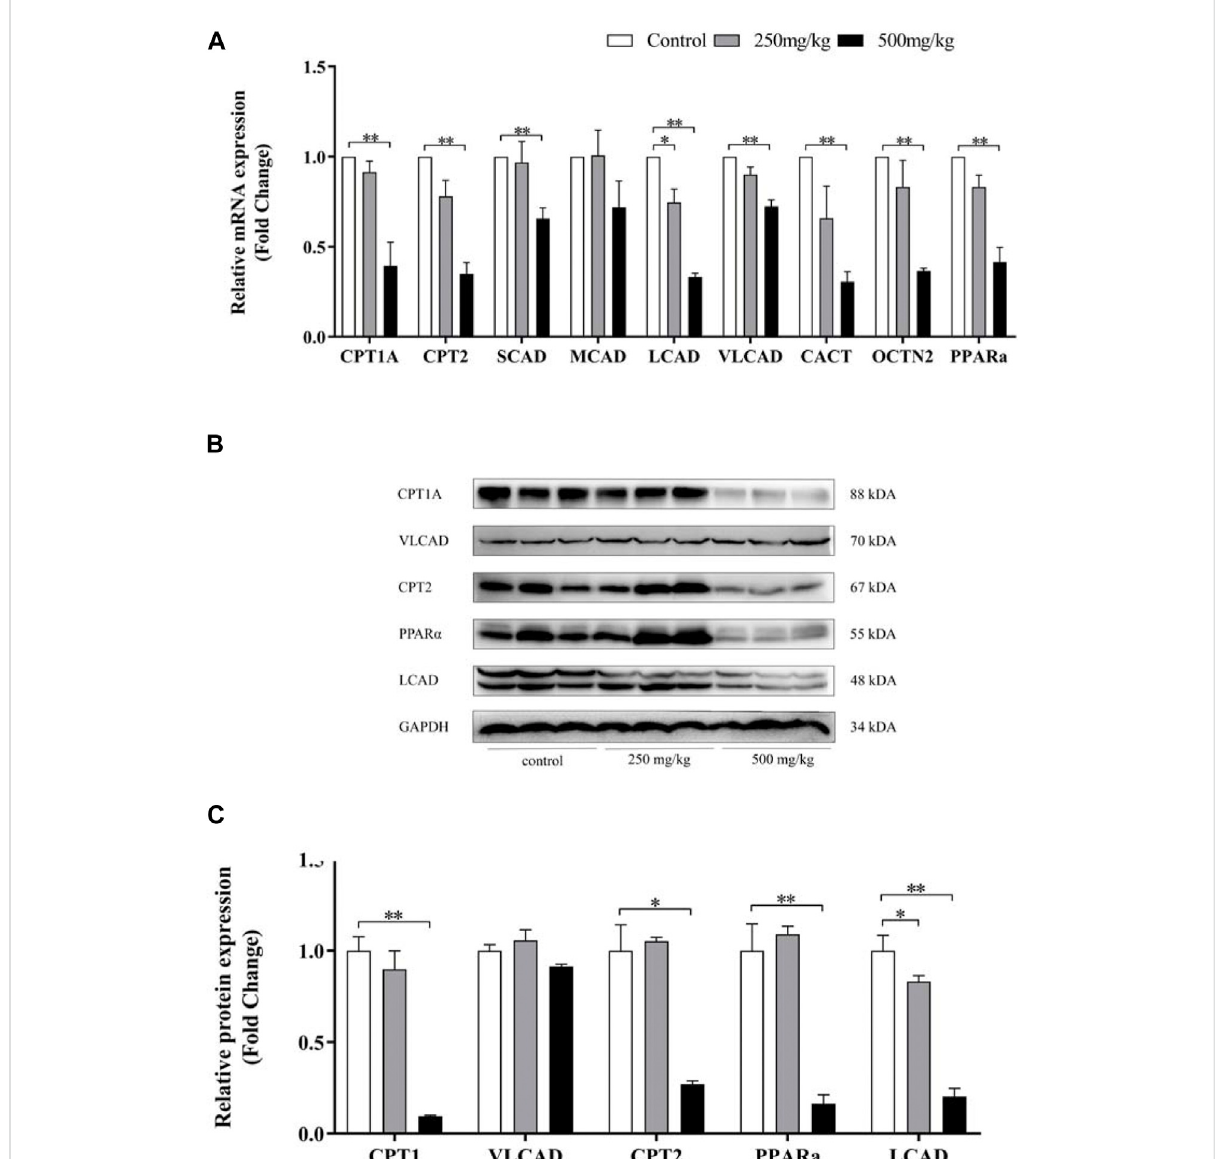
FIGURE 6 Effect of VPA on ACs-related gene expression in mouse livers. Real-time PCR analysis of the genes (A) and western blot analysis (B – C) of proteins involved in ACs metabolism. Data are expressed as the mean ± SD ( n = 6). *p < 0.05, **p <